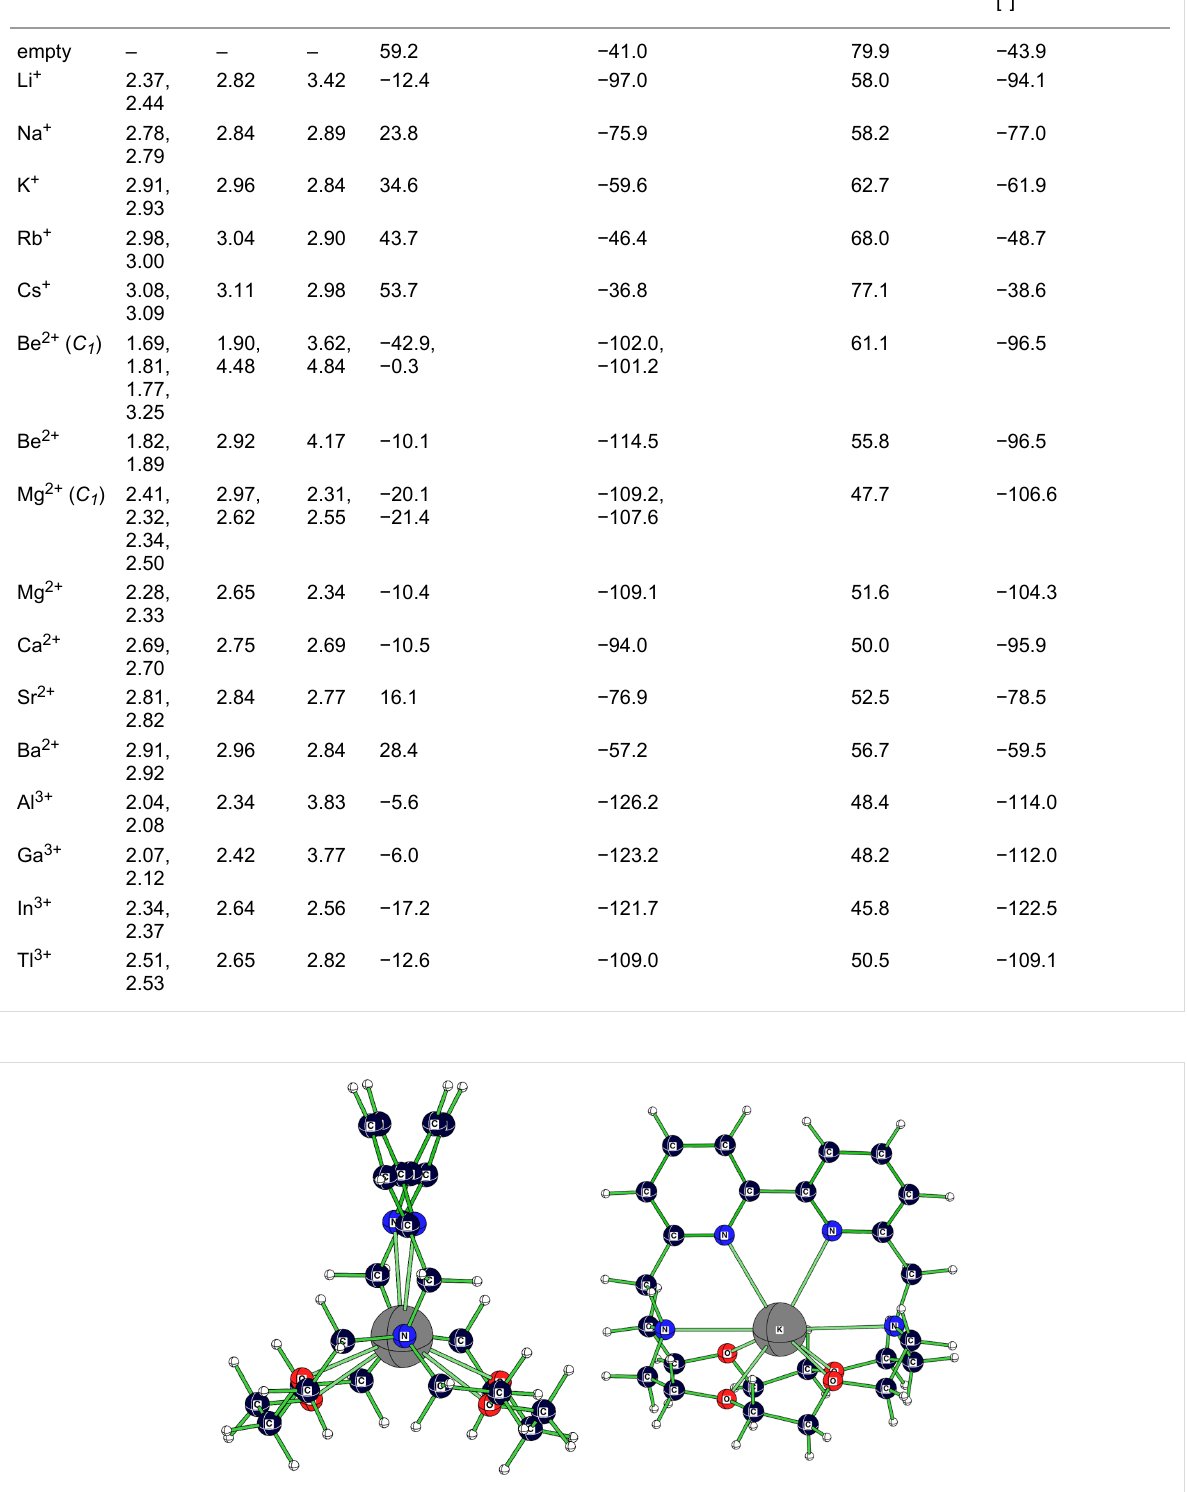
Figure 3: Calculated (RB3LYP/LANL2DZp) structure ( C 2 ) for [K 2.2.bpy] +